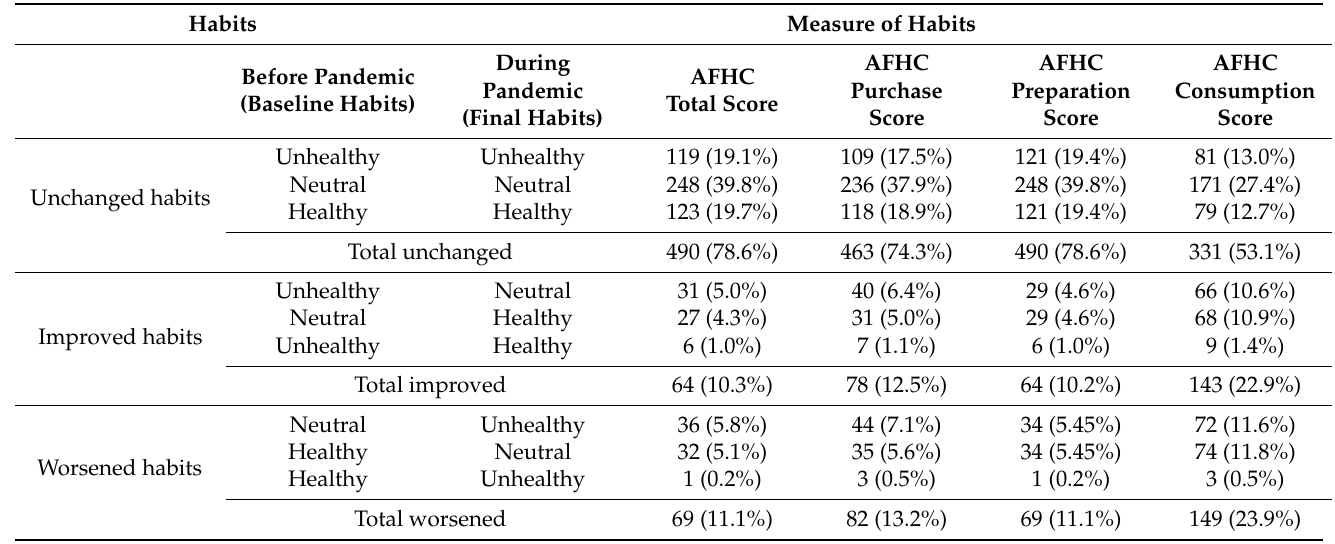
Table 8. The changes in Adolescents’ Food Habits Checklist (AFHC) scores during the COVID-19 pandemic, in categories of healthy, neutral, and unhealthy habits, for the population of male adolescents from the Diet and Activity of Youth during COVID-19 (DAY-19) Study ( n = 623).